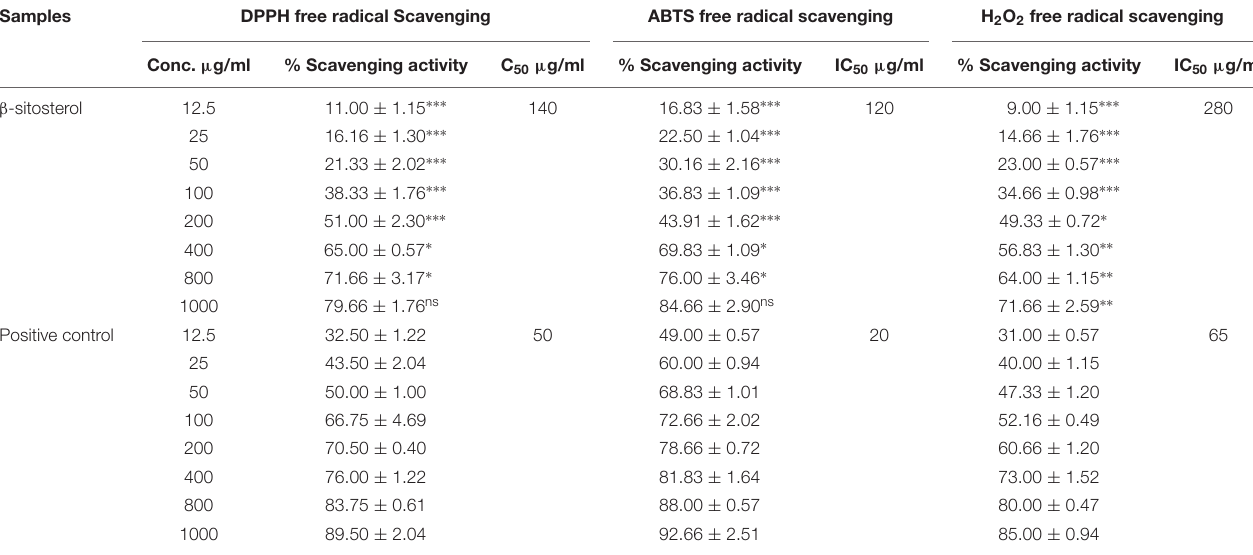
TABLE 3 | Antioxidant effect of β -sitosterol in the DPPH, ABTS and H 2 O 2 radicals scavenging assays.